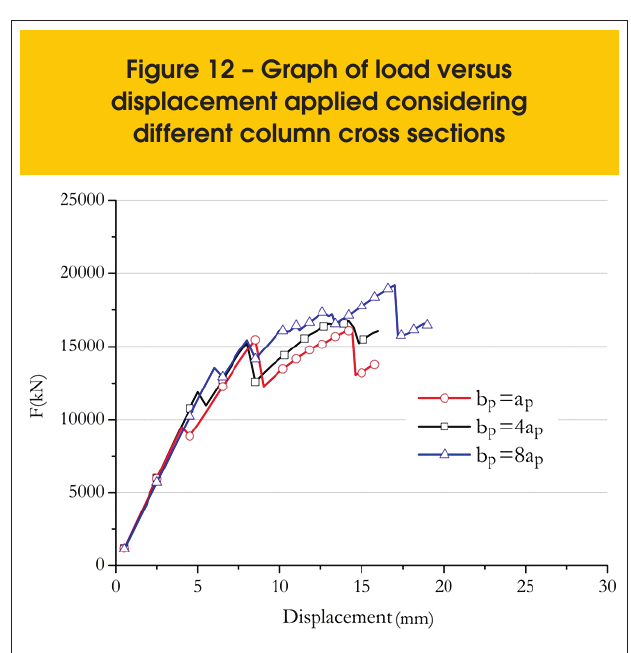
Figure 11 – Graph of percentage of total load resisted by each pile as load was applied. Pile caps with different column cross sections